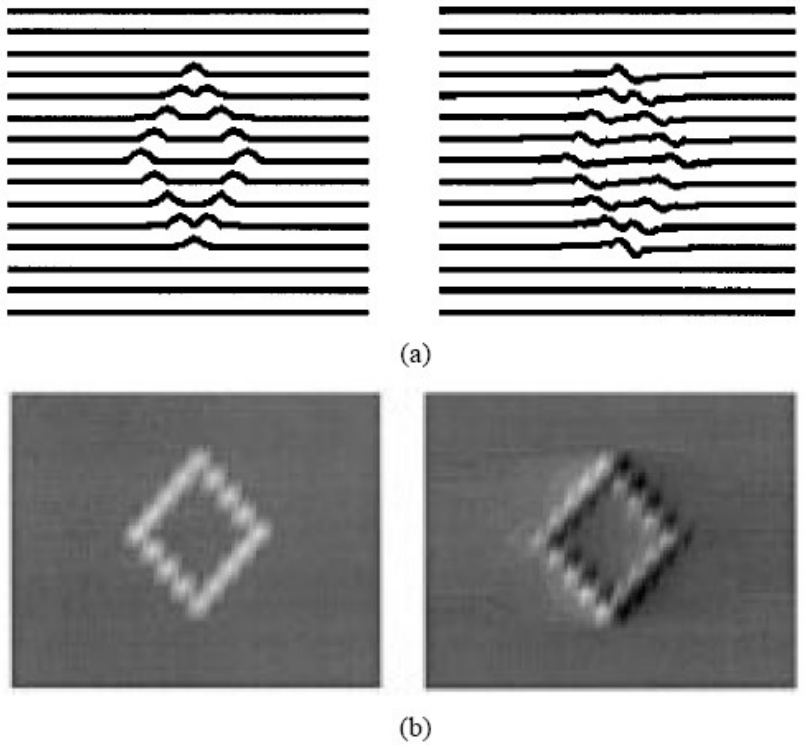
Figure 7. Composed images of the artificial grooved rhombic